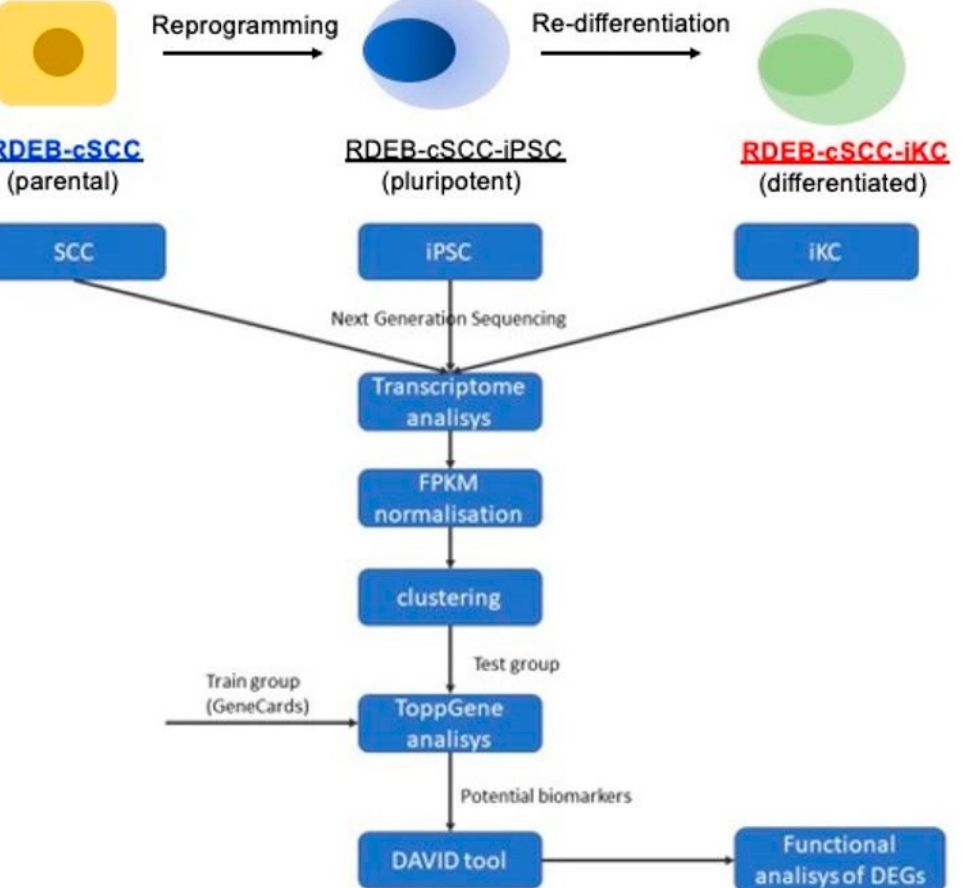
Figure 4. Schematic of bioinformatics analysis. General schematic demonstrating methods for RNA-seq analysis and comparison of gene expression profiles.